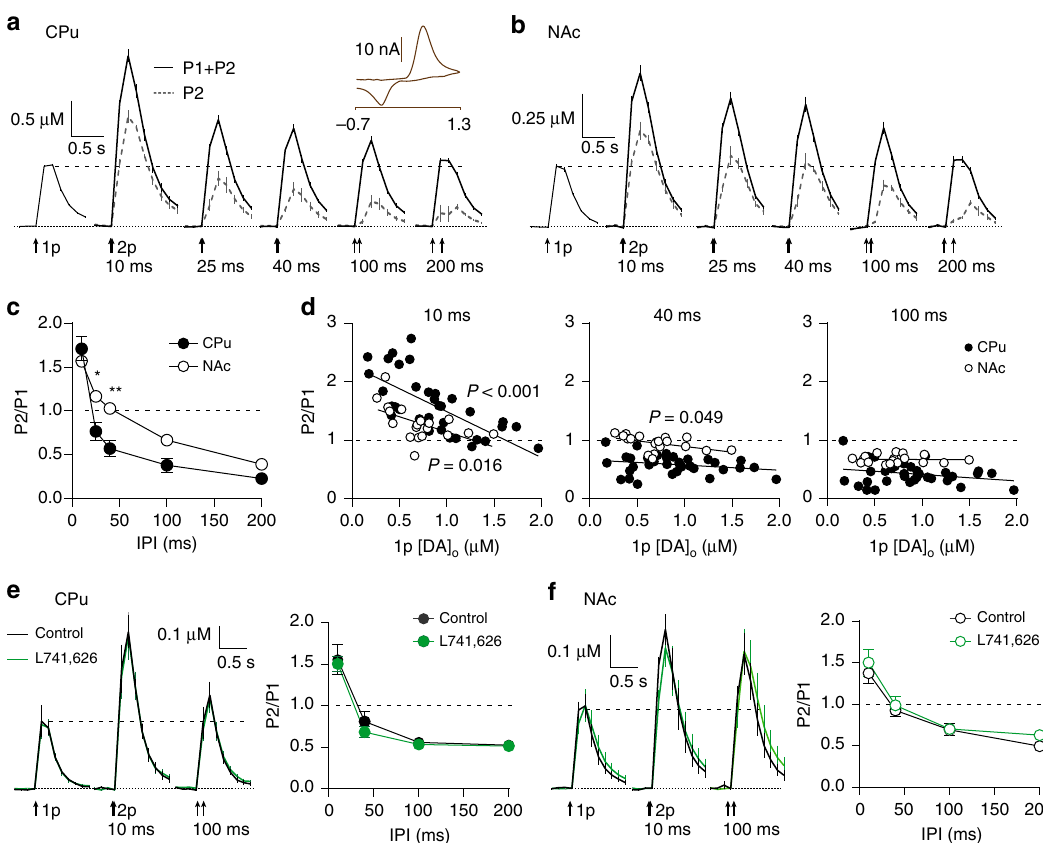
Fig. 1 Short-term plasticity at DA release sites is region-speci fi c and only weakly release-dependent. a , b Mean pro fi les of [DA] o transients elicited by single or paired electrical pulses (arrows) at IPI of 10 – 200 ms in CPu ( a , n = 4) and NAc ( b , n = 3). Dotted traces, [DA] o attributable to the second pulse, P2, in a pair ((P1 + P2) – P1). Inset, representative voltammogram for evoked DA release. c Mean P2/P1 vs IPIs in CPu ( fi lled circles) and NAc (open circles). Where error bars are not visible they fall within the bounds of the symbol. d P2/P1 vs peak 1p-evoked [DA] o for IPIs of 10 ms (left), 40 ms (centre) and 100 ms (right). Each data point is 1 site in CPu ( fi lled circles, n = 35) or NAc (open circles, n = 19). Linear fi ts to data show P -values (F-test) to indicate whether the slope is signi fi cantly > 0. e , f (Left) Mean pro fi les of [DA] o transients in CPu ( e , n = 5) and NAc ( f , n = 6) in control conditions vs L741,626 (1 µ M, green). (Right) Mean P2/P1 vs IPIs in control conditions and L741,626 in CPu ( e ) or NAc ( f ). Two-way ANOVA with Bonferroni ’ s test for post hoc comparisons: * P < 0.05, ** P < 0.01. Error bars are ± SEM. Source data are provided as a Source Data fi